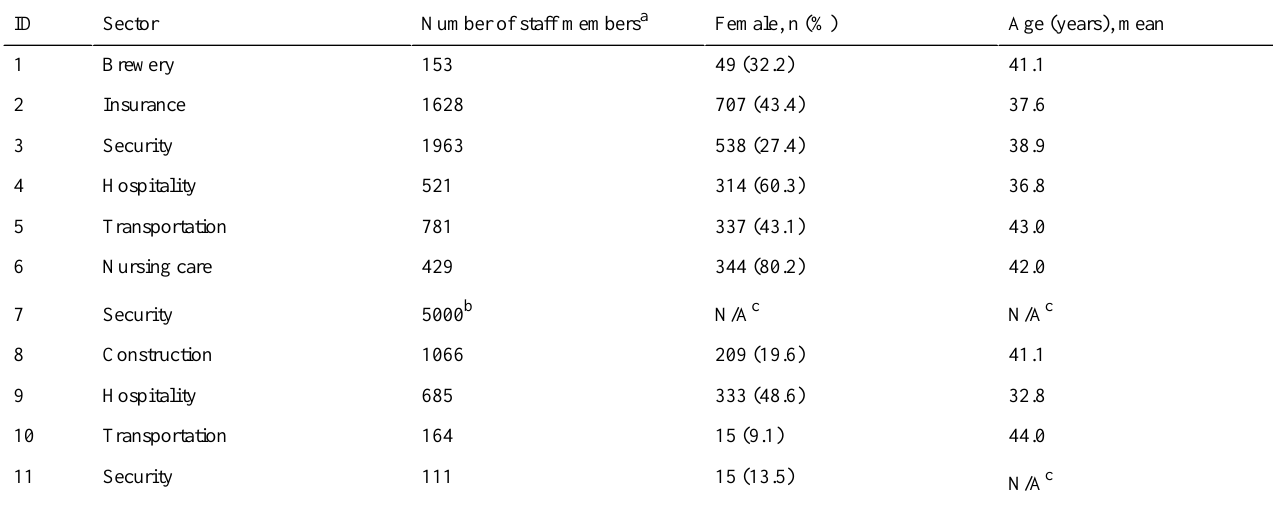
Table 1. Overview of each organization’s staff